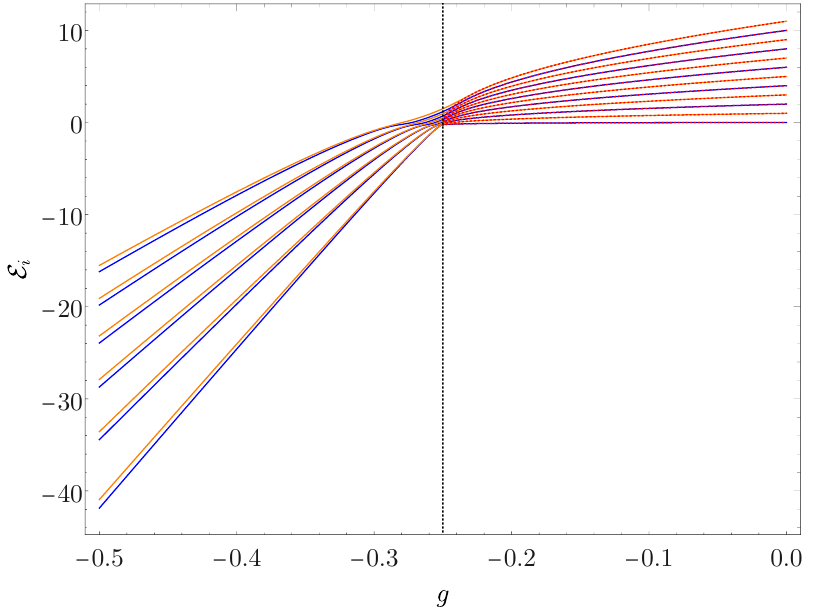
Figure 42. Spectrum of the cutoff Hamiltonian H N ( g ) for N = 50 for g ∈ [ − 1 / 2 , 0] . The blue (resp. orange) curves have even (odd) Z spectrum of the theory; the vertical black dotted line indicates g